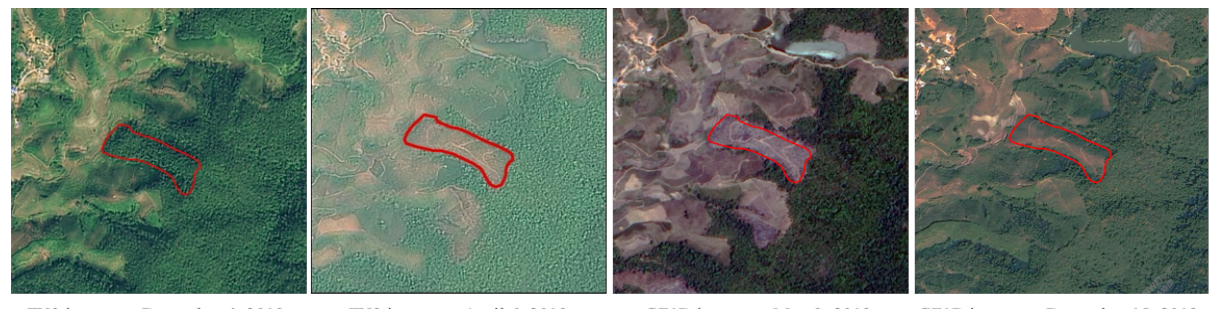
Figure 2. Parcel 01 in Xishuangbanna Nature Reserve